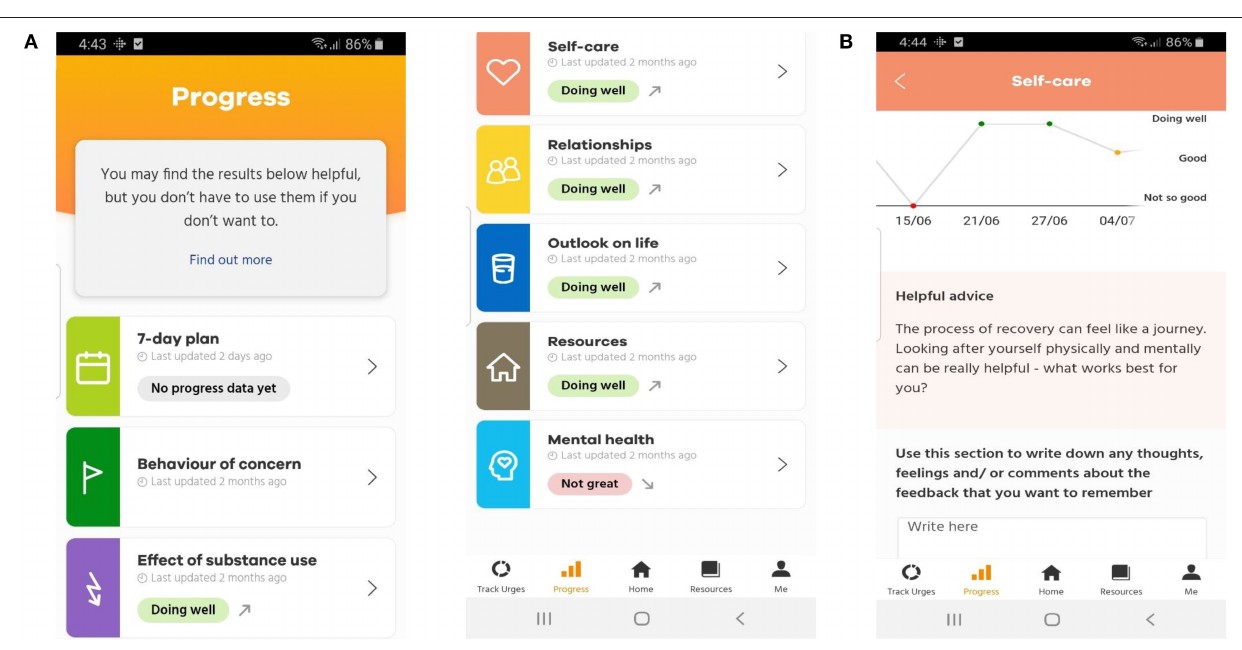
Frontiers in Psychiatry |